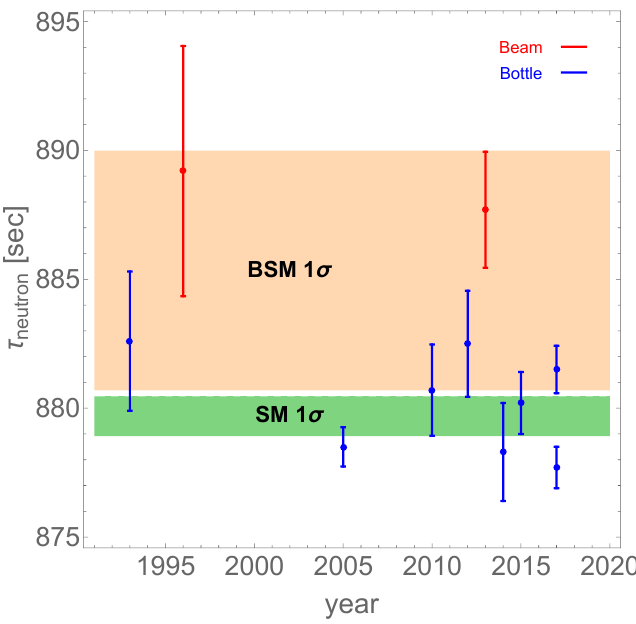
Figure 6 . Neutron lifetime prediction in a global fit that includes all other measurements listed in appendix B. Bottle measurements are favored in the SM fit (green band) but not in the BSM scenario with only left-handed neutrinos (salmon band) (cf. section 4.2).